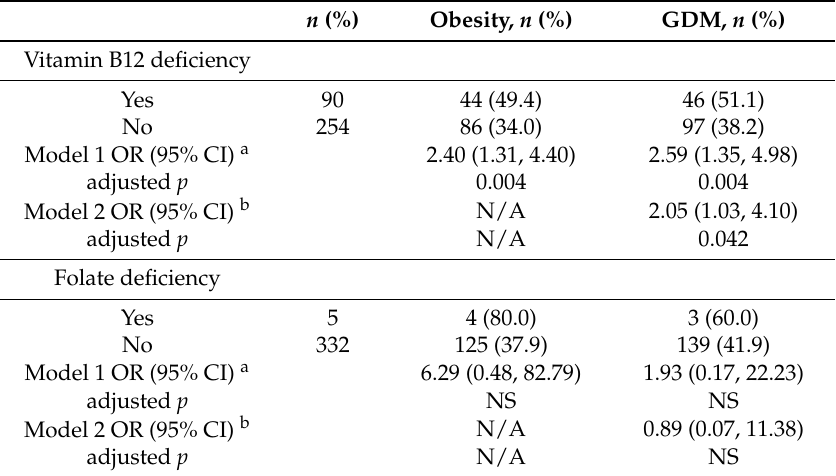
Table 3. Relationship of maternal B12 and folate with obesity and gestational